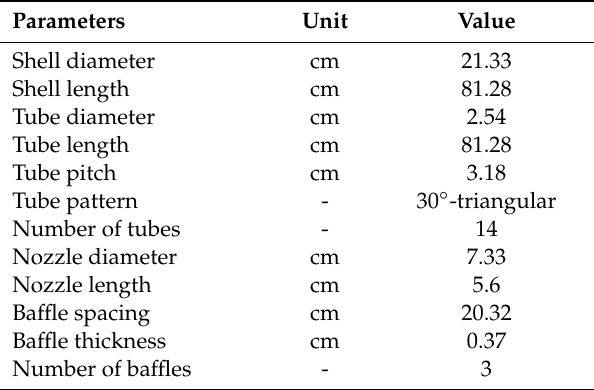
Table 2. Geometric dimensions of the multi ‐ tubular reactor.